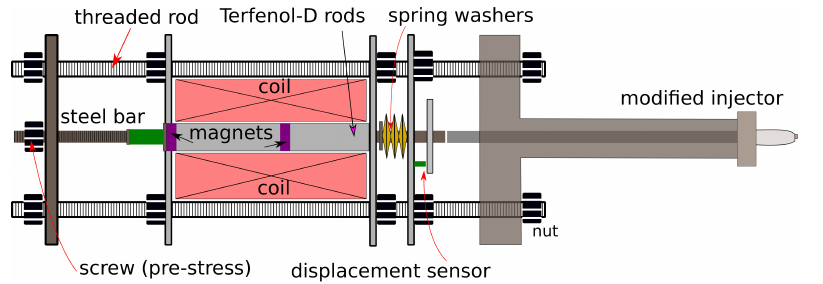
Figure 1. Scheme of the modified injector with the integration of a custom magnetostrictive actuator over a standard fuel injector.